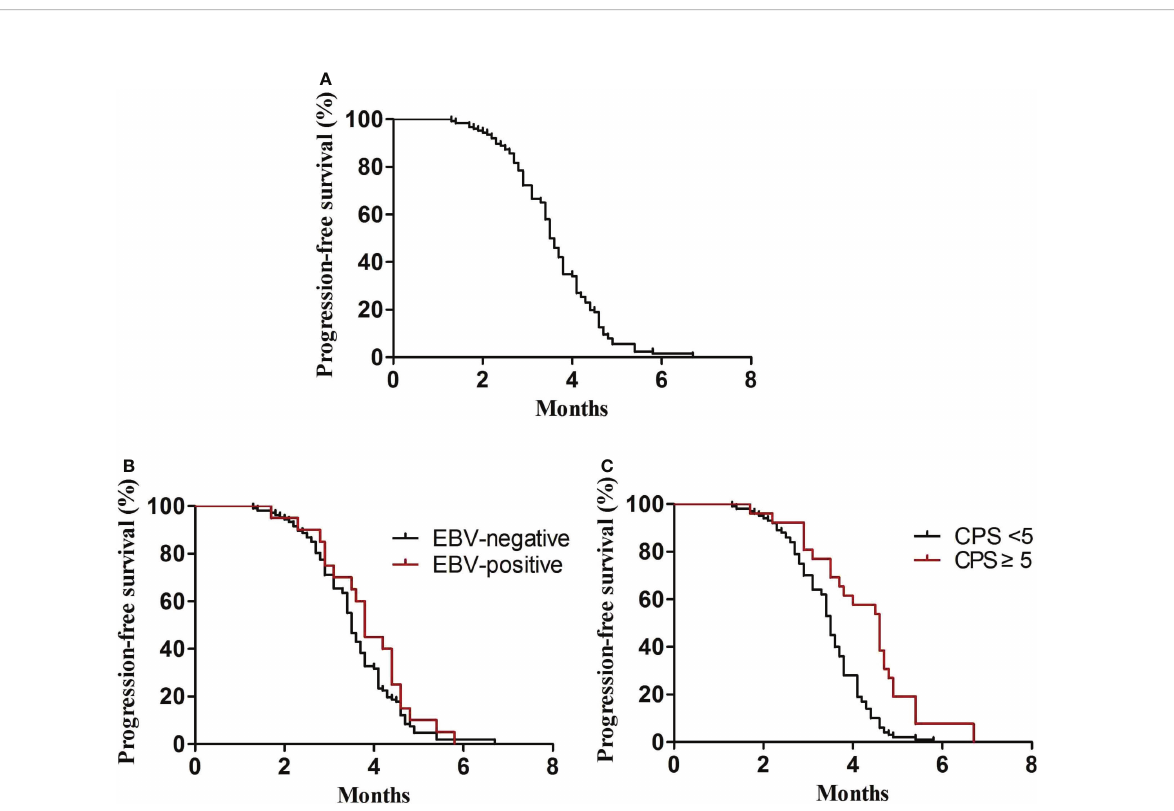
FIGURE 3 PFS3. (A) Kaplan – Meier plots for PFS3 in the third-line treatment. (B) PFS3 according to PD-L1 (P = 0.02). (C) PFS3 according to EBV (P =